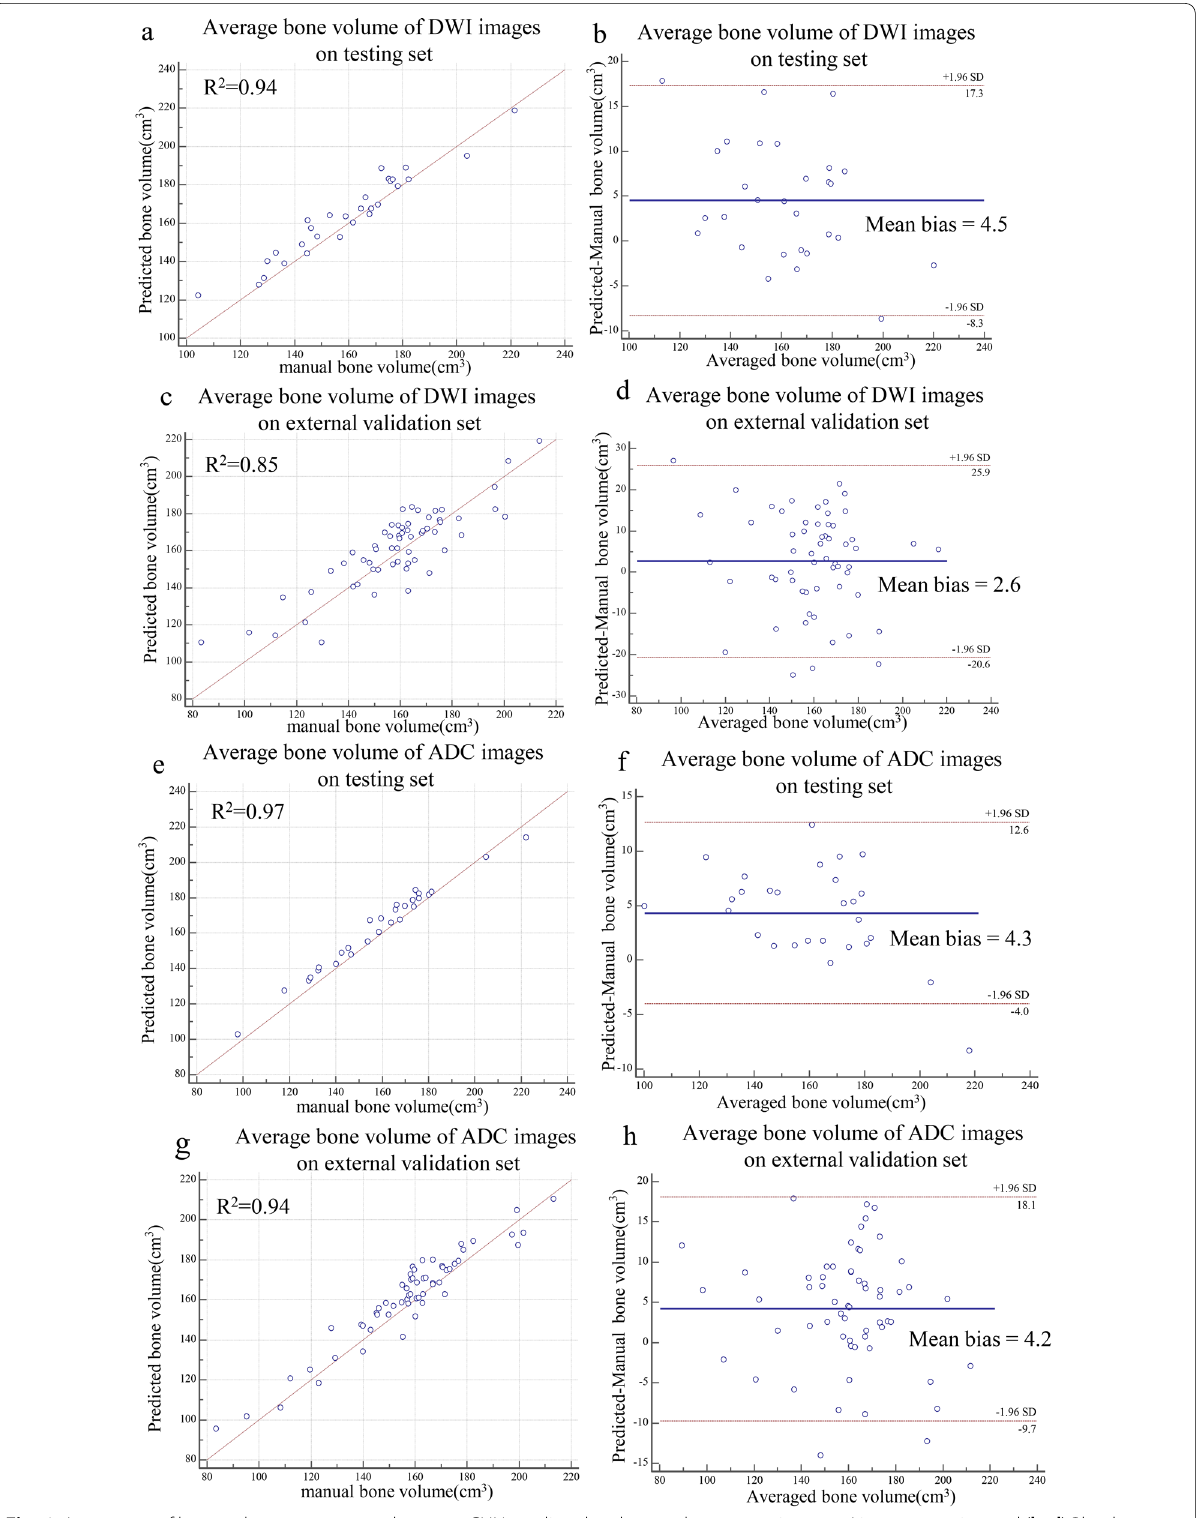
Fig. 6 Agreement of bone volume assessments between CNN-predicted and manual segmentations. a , c Linear regression and ( b , d ) Bland– Altman analysis of bone volume assessments from DWI images. e , g Linear regression and ( f , h ) Bland–Altman analysis of bone volume estimates from ADC